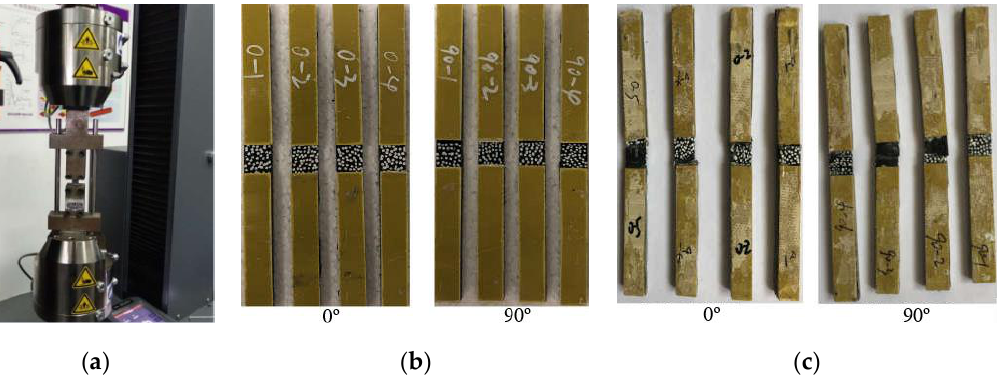
Figure 5. Uniaxial compression tests at 0° and 90° layer: ( a ) Test machine; ( b ) Uniaxial compression specimen; ( c ) Failure forms of specimens.